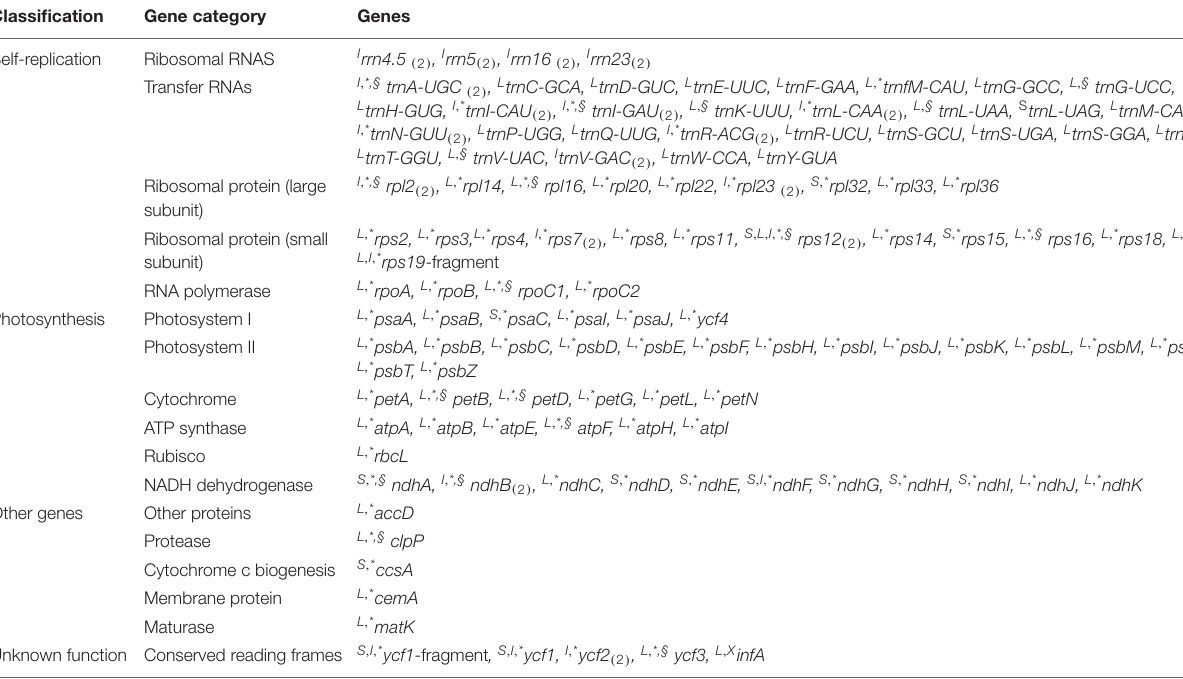
TABLE 2 | List of the 115 identified unique genes of Rosaceae plastomes.